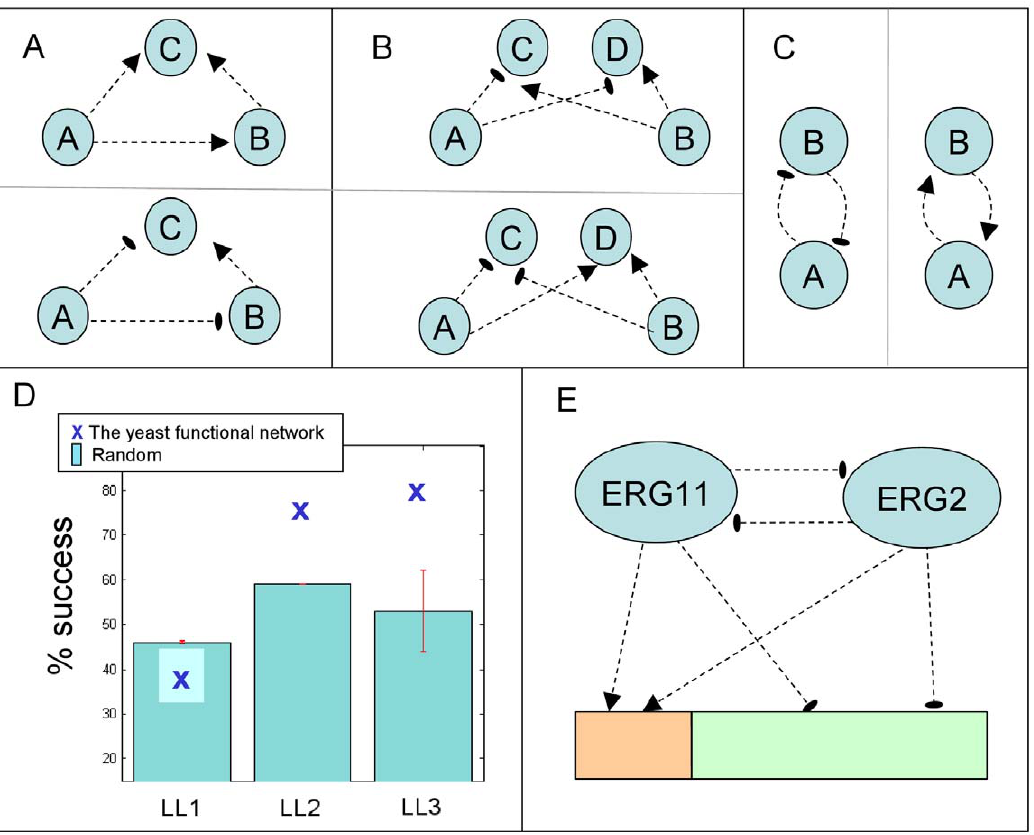
Figure 3. Evaluating local linearity properties of the functional network. Edges represent functional relations with down-regulation relations depicted as regular arrows and up-regulations as cut-arrows. (A) LL-1: if knocking out genes a or b has a similar (opposite) effect on a shared target c , then if a affects b the relation should be down-regulation (up-regulation). (B) LL-2: for two knocked out genes ( a , b ) with at least two common targets ( c , d ) , the respective influences should be either equivalent (bottom) or the exact opposite (top). (C) LL-3: If two genes ( u , v ) affect each other then the effects should have equal signs. (D) The prevalence of the three properties in the original data and in randomized networks. (E) An example for the violation of LL-1 in the biosynthesis of steroids pathway. Two pathway members, ERG11 and ERG2, that increase each other upon knockout, have the exact same effect on all their common targets, down-regulating 110 genes (orange rectangle) and up-regulating 308 genes (green